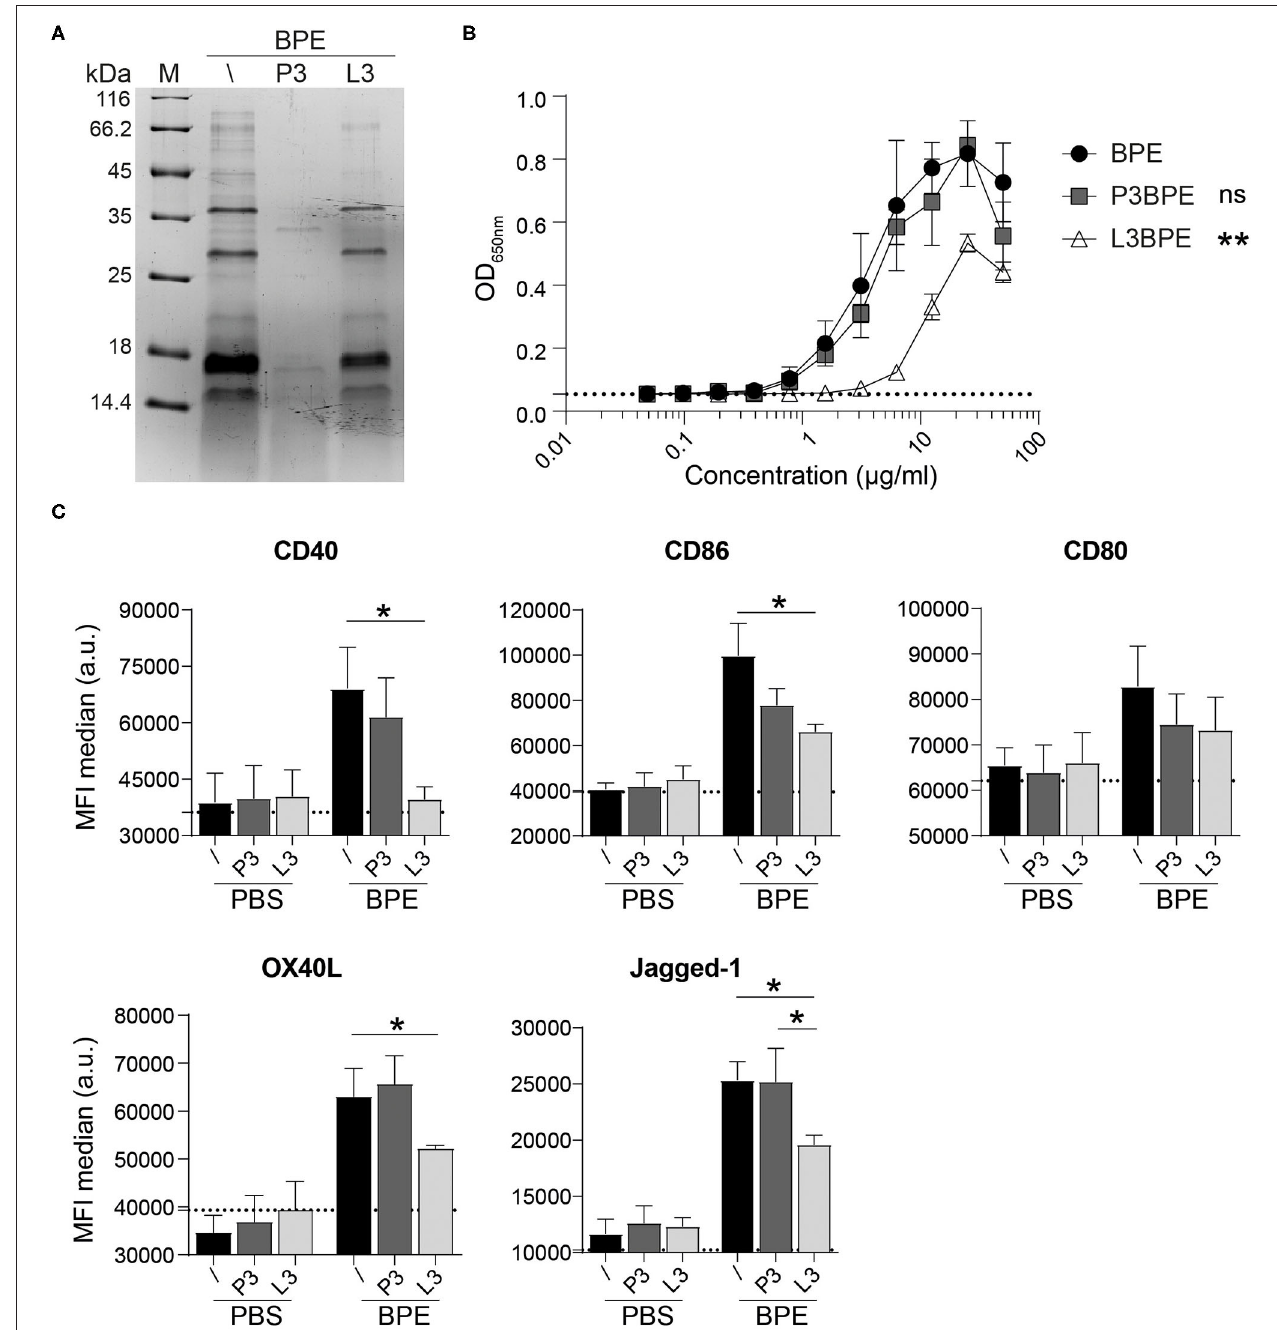
FIGURE 3 | BPE-derived lipids rather than proteins contribute to the BPE-induced TLR4 signaling and BMDC activation. Coomassie Brilliant Blue-stained SDS-PAGE visualization of untreated (/), protein-free (P3), and lipid-free (L3) fractions of BPE (A) . The TLR4 signaling capacity of P3BPE and L3BPE compared to untreated BPE was analyzed in the mTLR4 HEK assay (B) . For statistical analysis, a One-Way ANOVA of the AUC with a Dunnett’s multiple comparisons test was used comparing the fractions with untreated BPE. Surface expression of the costimulatory molecules CD40, CD86, CD80, and the Th2-associated markers OX40L and Jagged-1 was analyzed in Balb/c BMDCs upon stimulation with BPE (60 µ g/ml), P3BPE, L3BPE, or the corresponding PBS controls (C) . Dotted lines represent the average of medium-treated cells. Statistics were computed by a One-Way ANOVA with a Tukey’s multiple comparisons test.